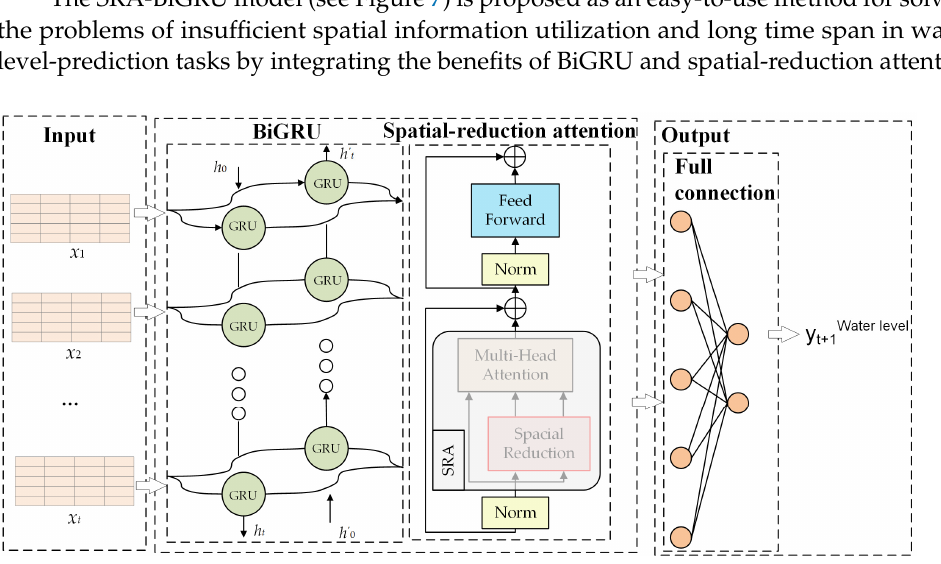
Figure 7. Schematic diagram of the SRA-BiGRU model.